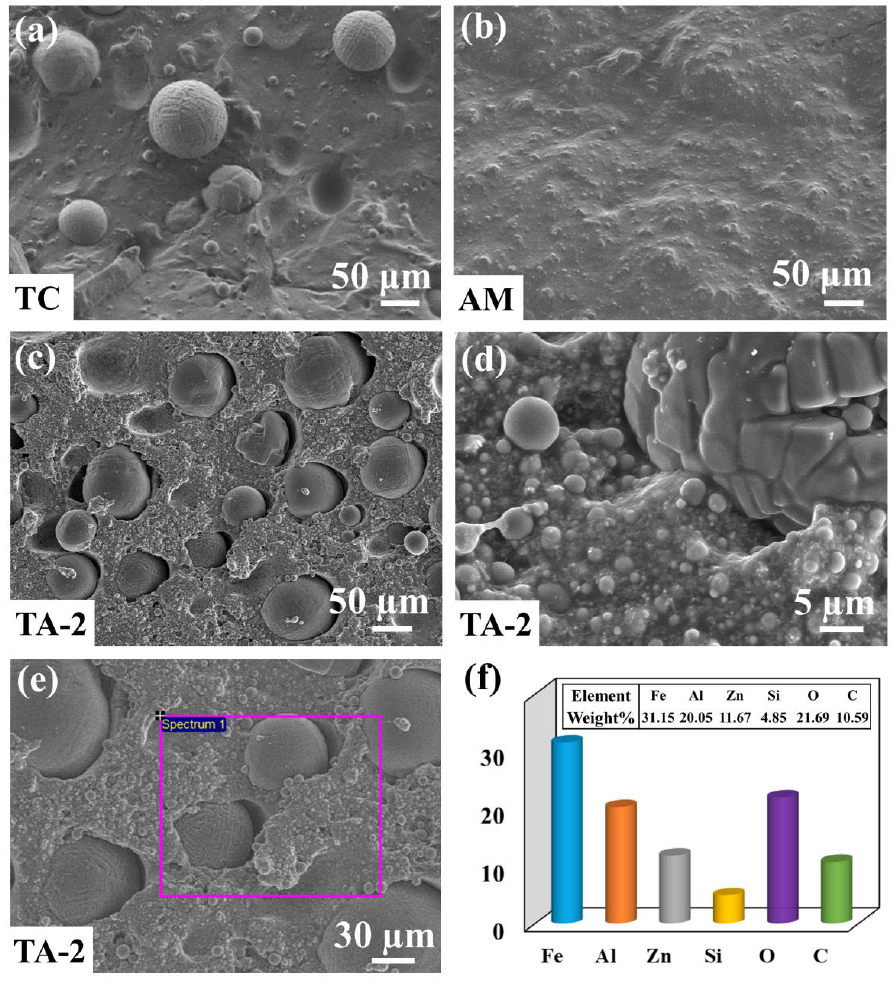
Figure 3. Cross-sectional SEM images of composites: ( a ) TC; ( b ) AM; ( c , d ) TA-2. ( e , f ) Element content maps for EDS analysis of selected portions of composite TA-2.